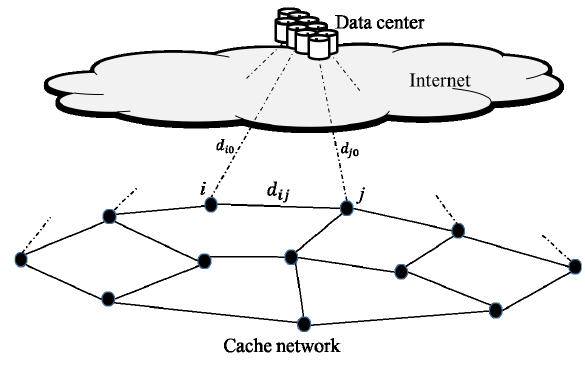
Figure 1. Data cache network.